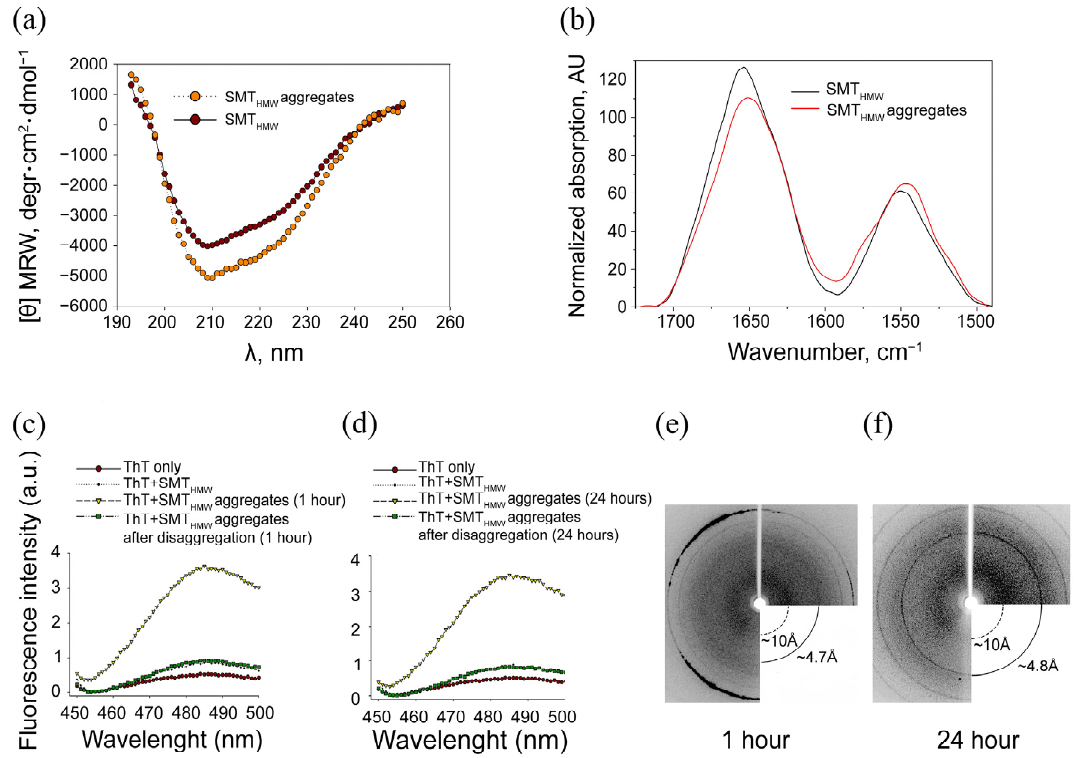
Figure 5. Investigation of the structure of SMT HMW aggregates by various methods. ( a ) CD spectrum of SMT HMW ; ( b ) FTIR spectra of titin and its aggregates at 20 °C. Protein concentration was 10 mg/mL;